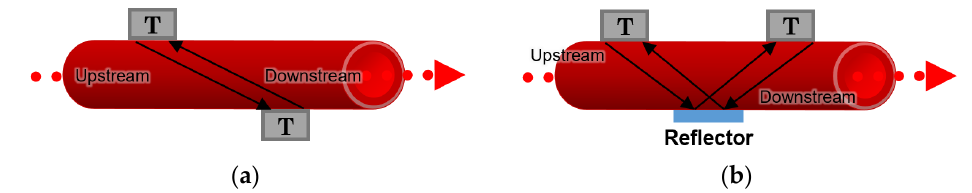
Figure 10. Illustration of both schemes of transit-time flowmeters: ( a ) transducers (T) placed diagonally; ( b ) transducers on one side with a reflector on the opposite side of the blood vessel or artificial channel.